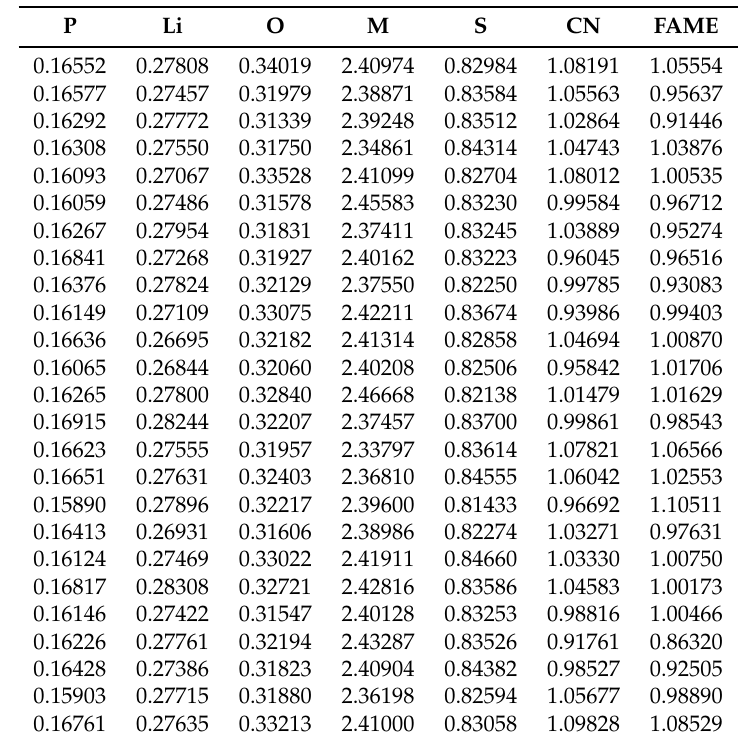
Table 5. Mean absolute deviation percent (MADP) of output variables, i.e., compositions, flow rate and cetane number, from their respective measured